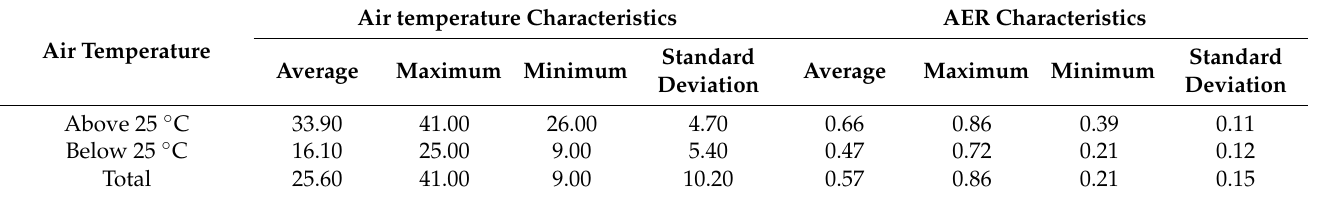
Table 5. Statistics of AER characteristics of different temperature ranges during the